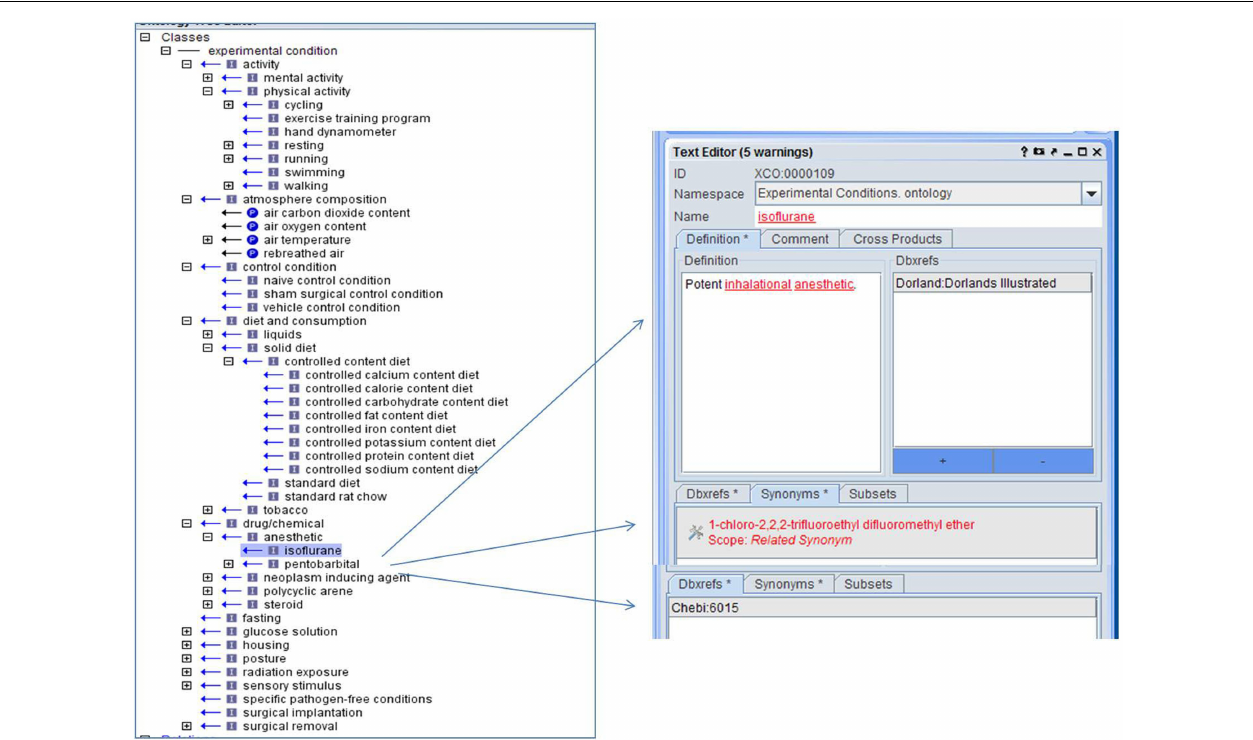
FIGURE 5 |The Experiment Condition Ontology is structured by type of condition with both “is_a”and “part_of”relationships with links to identifiers found in other